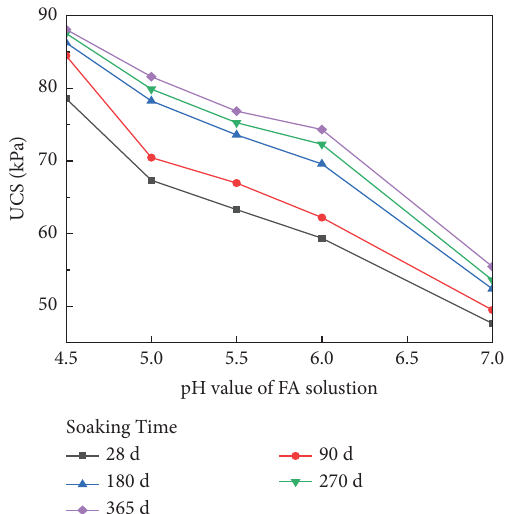
Figure 5: Relationship curve between sample UCS and pH value of FA